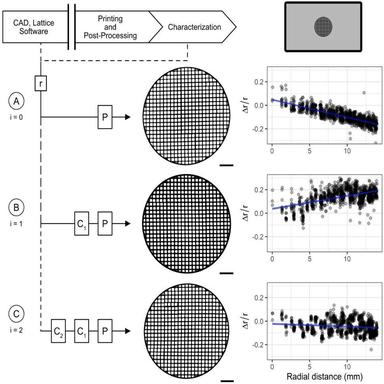
Compensation schemes and strut radius deviation from each iteration of curing compensation (n = 3 replicates per iteration). (A) First iteration, no compensation. (B) Second iteration, single-stage compensation. (C) Third iteration, two-stage compensation. Scale bar is 5 mm.